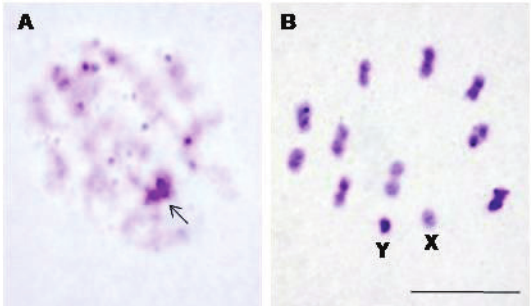
Figure 11. Constitutive heterochromatin pattern in R. taquarussuensis . A Initial prophases with a chro- mocenter heterochromatic consisting of sex chromosomes (arrow) and several heterochromatic blocks dispersed in the nucleus B Metaphase I with heterochromatic blocks in both extremities of practically all the autosomes and in the Y sex chromosome. X: X sex chromosome, Y: Y sex chromosome. Bar: 10 μm.